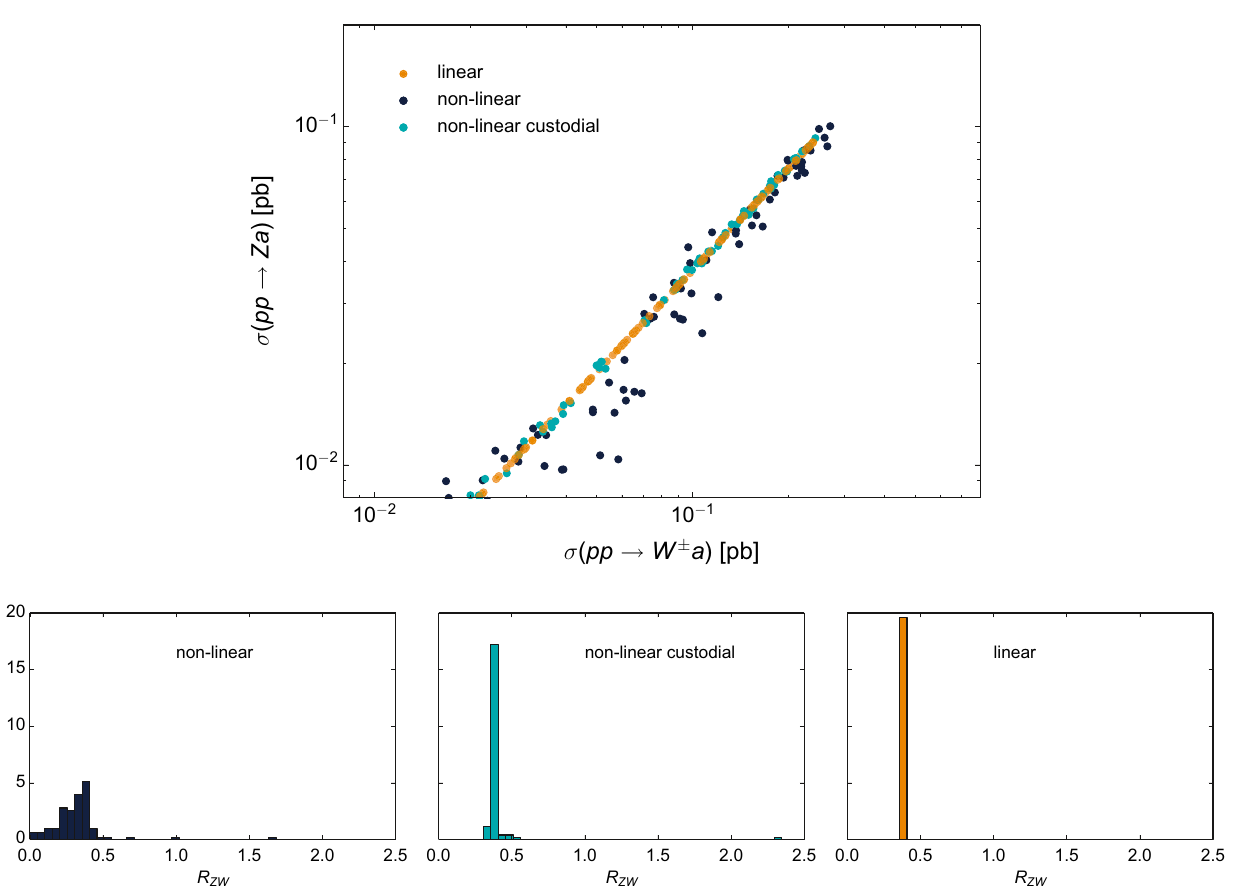
√ s = of the ratio R ZW defined in Eq. (86), with the area of the histograms normalised to 1. In both cases, orange , cyan and dark blue correspond, respectively,tolinear,non-linearcustodialandnon-linearnon-custodial